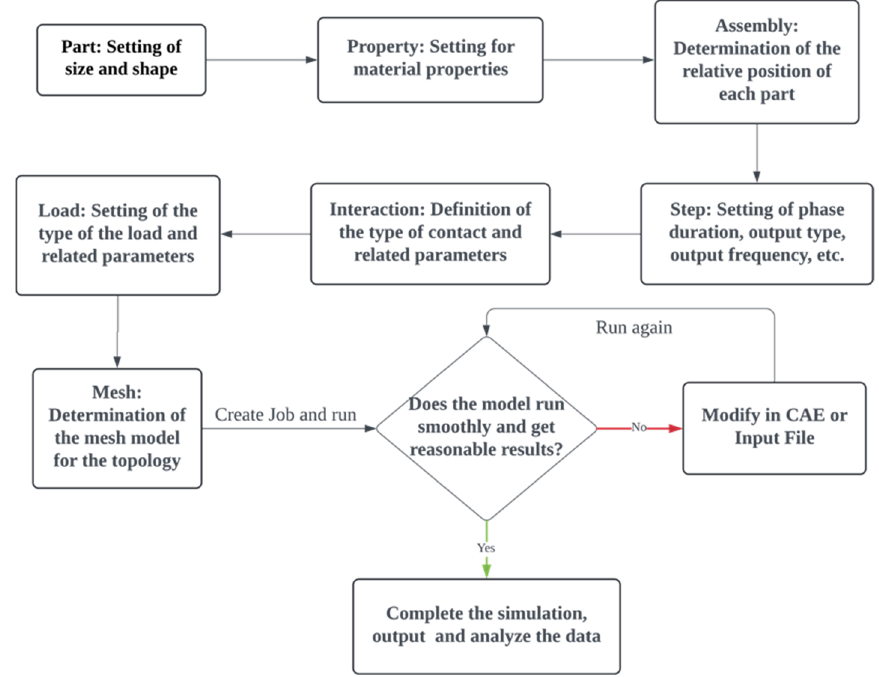
Figure 1. Flowchart of the FEM-DEM coupled modeling.